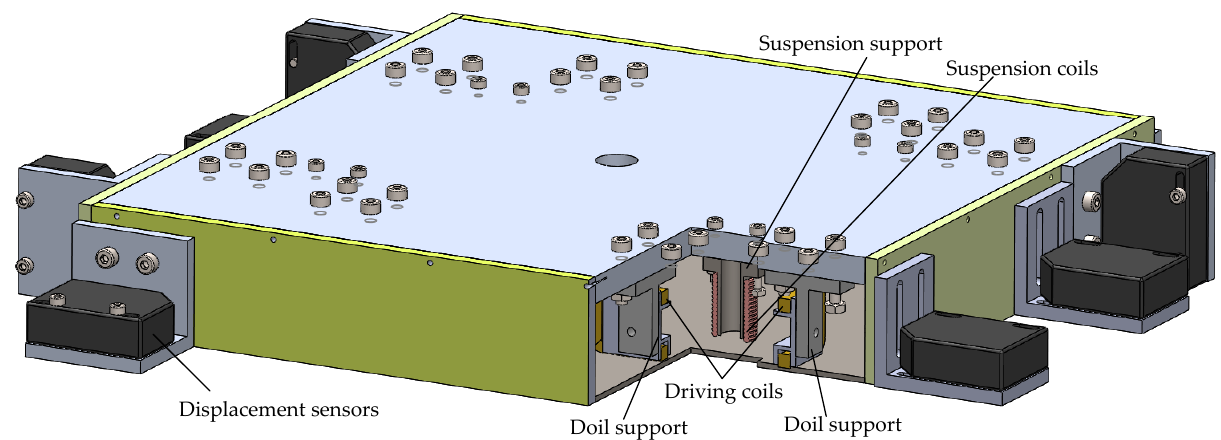
Figure 3. Structure of the 6-DOF magnetic suspension platform’s